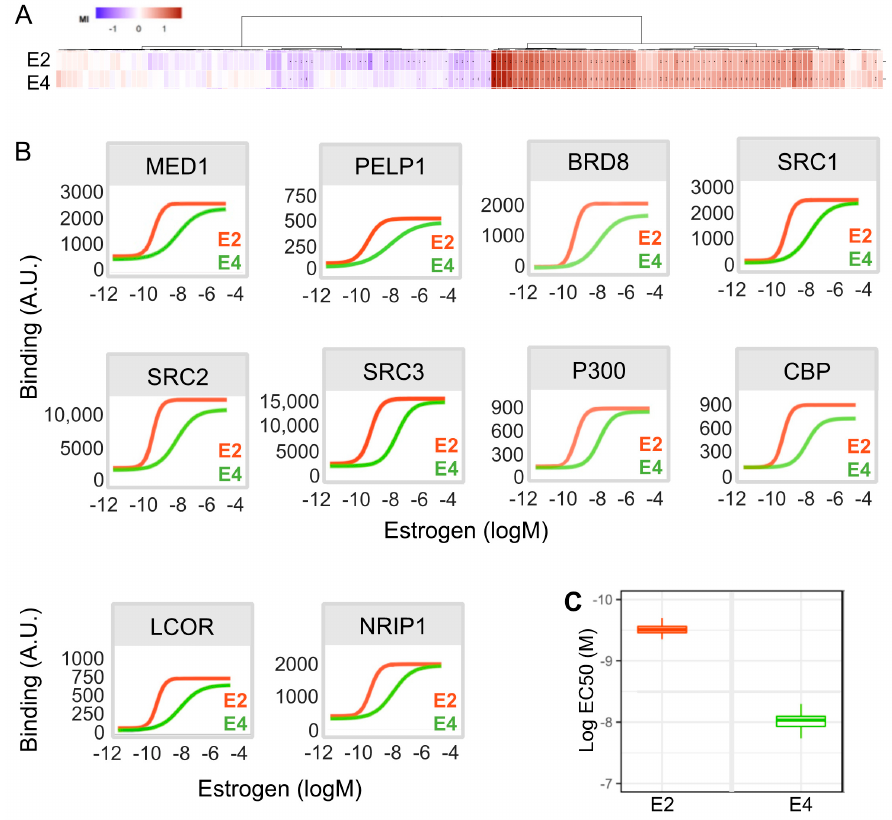
Figure 7. E2- and E4-specific co-regulator binding profiles. ( A ) Heatmap of interactions between ER α and co-regulators induced by E2 or E4 and represented as the modulation index (MI). MI is expressed as a log of fold-changes relative to the